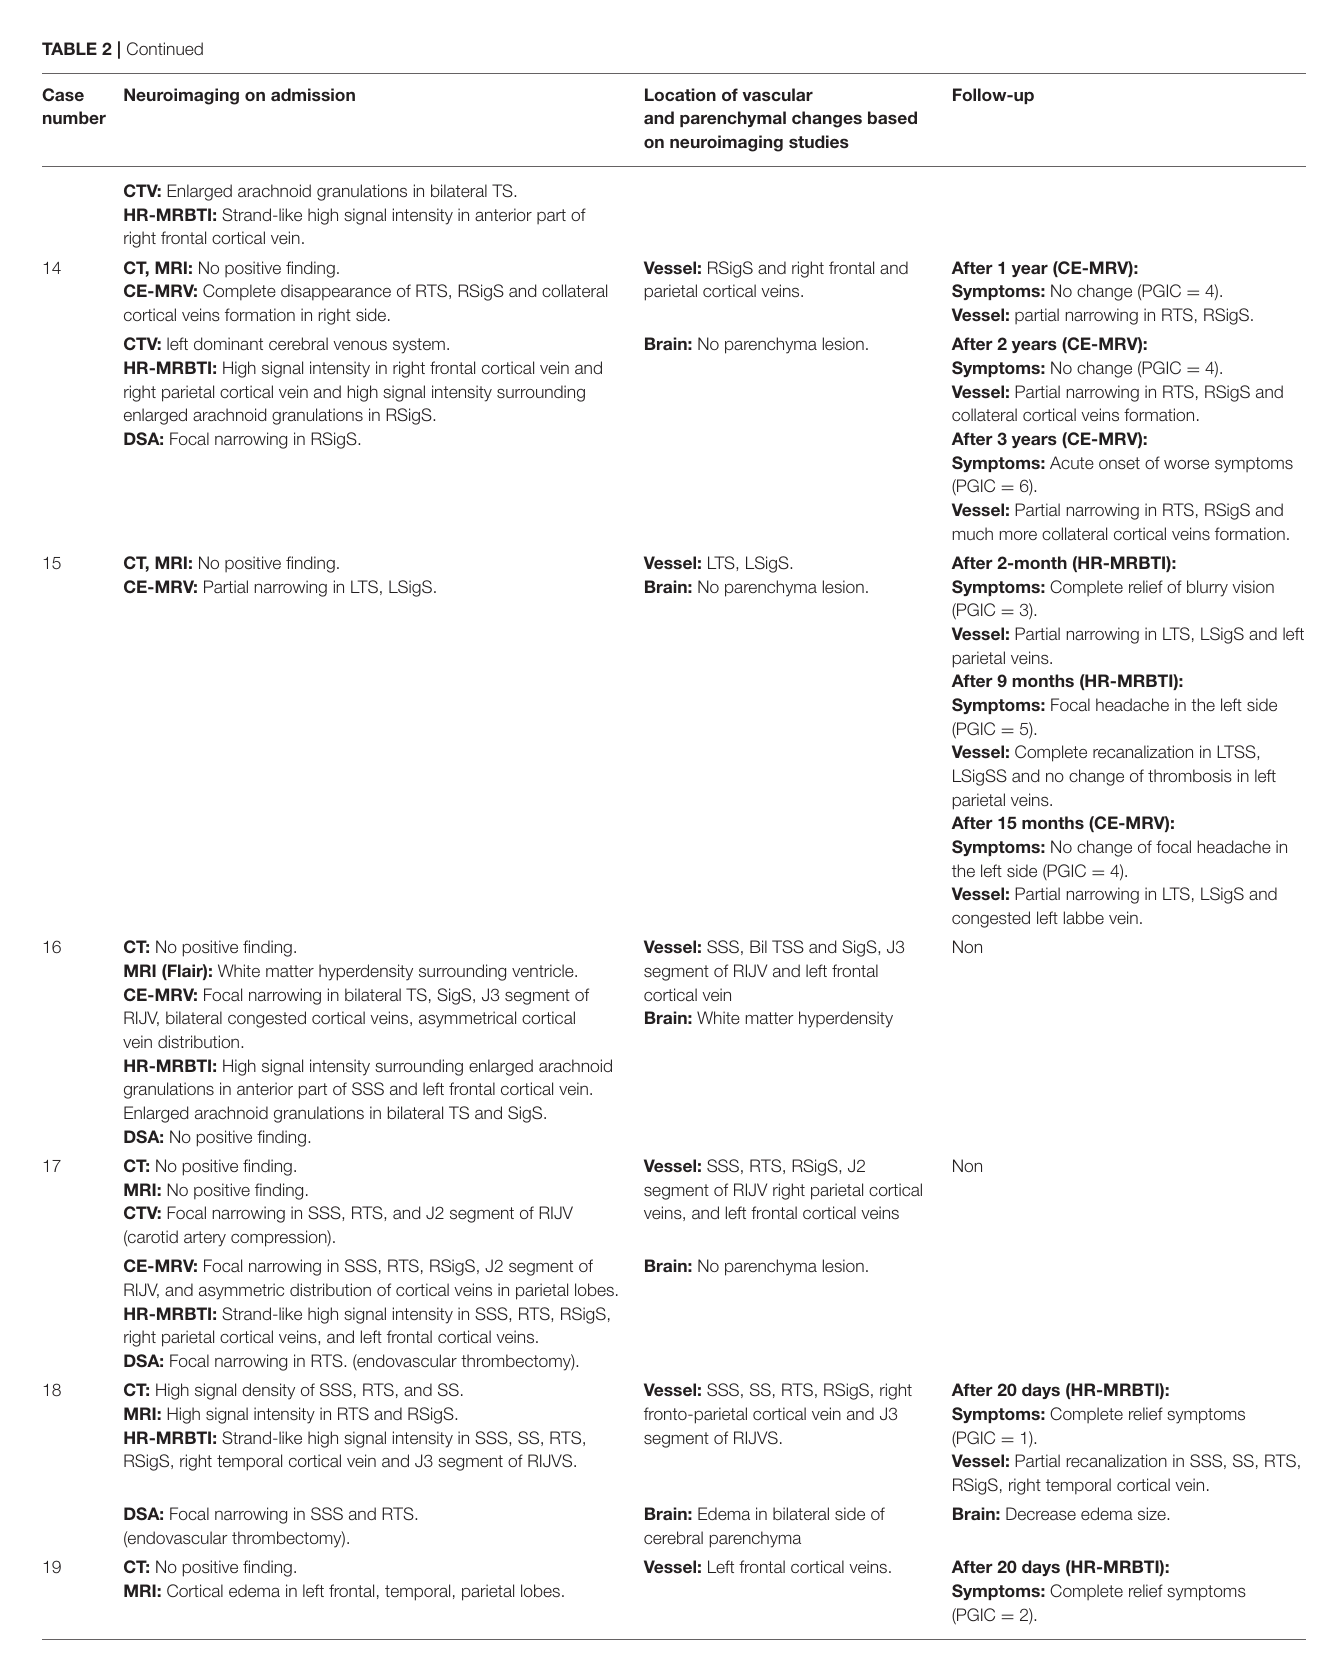
Vessel: Left frontal cortical